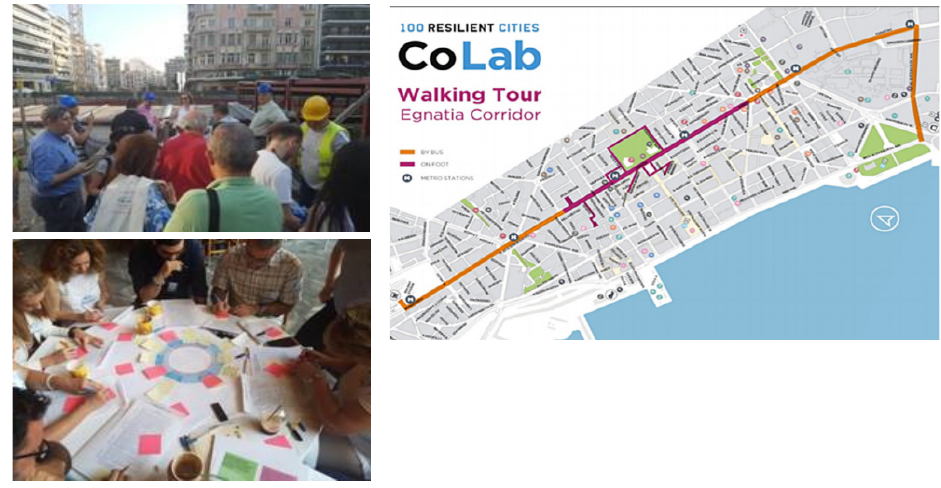
Figure 4. Colab June 2018—City Hall Thessaloniki. Source: Resilient Thessaloniki office archive.